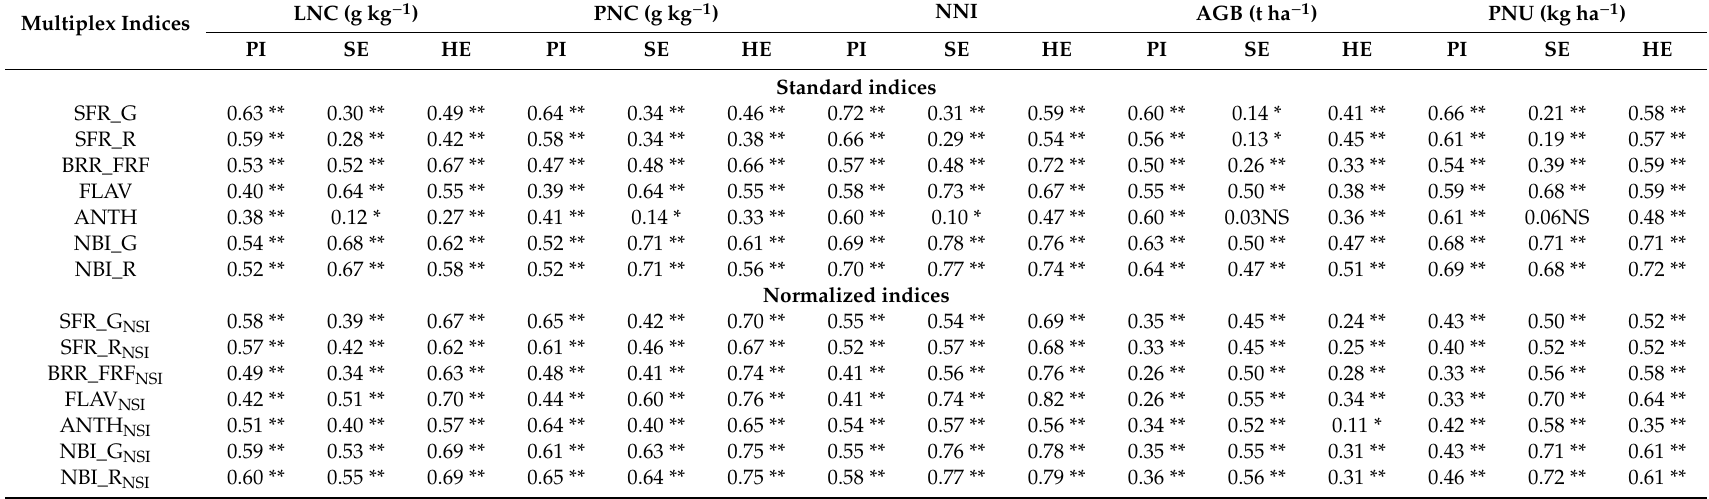
Table 4. The coe ffi cients of determination (R 2 ) for the linear relationships between standard and normalized Multiplex indices and N status indicators (leaf N concentration (LNC), plant N concentration (PNC), N nutrition index (NNI), aboveground biomass (AGB) and plant N uptake (PNU)) for two varieties at the panicle initiation (PI), stem elongation (SE), and heading (HE) growth